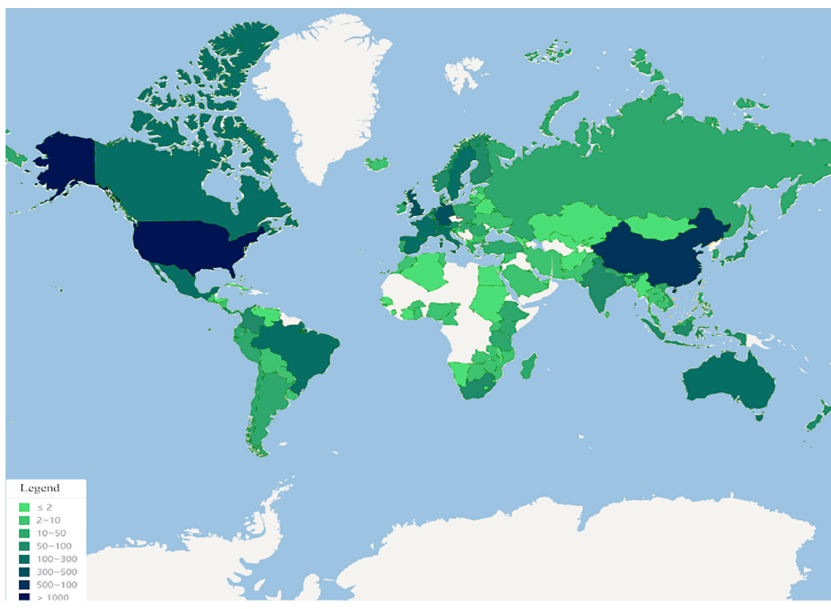
Figure 3. Global distribution of SMBD publications.